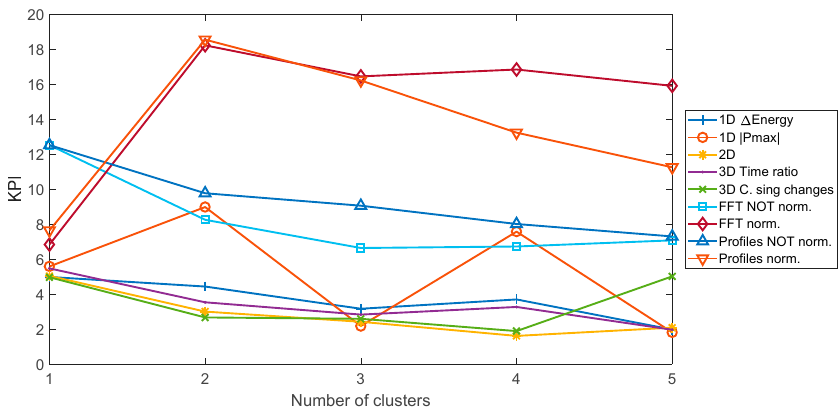
Figure 7. KPI trends as a function of clustering features and number of clusters.